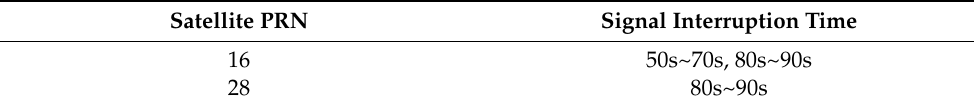
Table 4. Signal interruption time and satellite Pseudo Random Noise(PRN) code